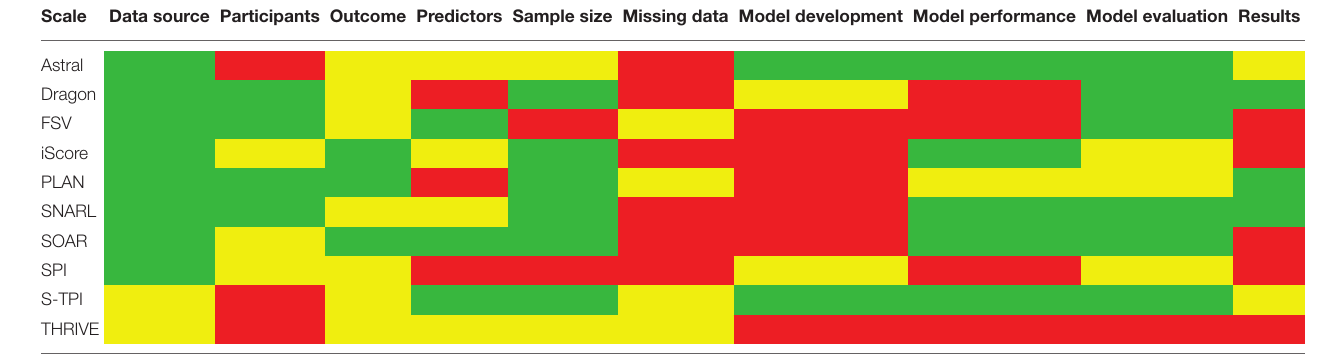
TABLE 5 | Assessment of risk of bias in scale derivation